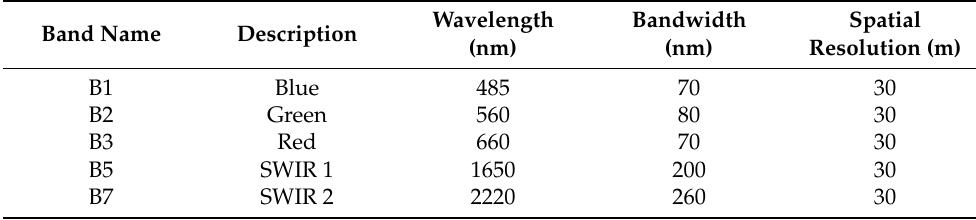
Table 2. Description of Landsat-7